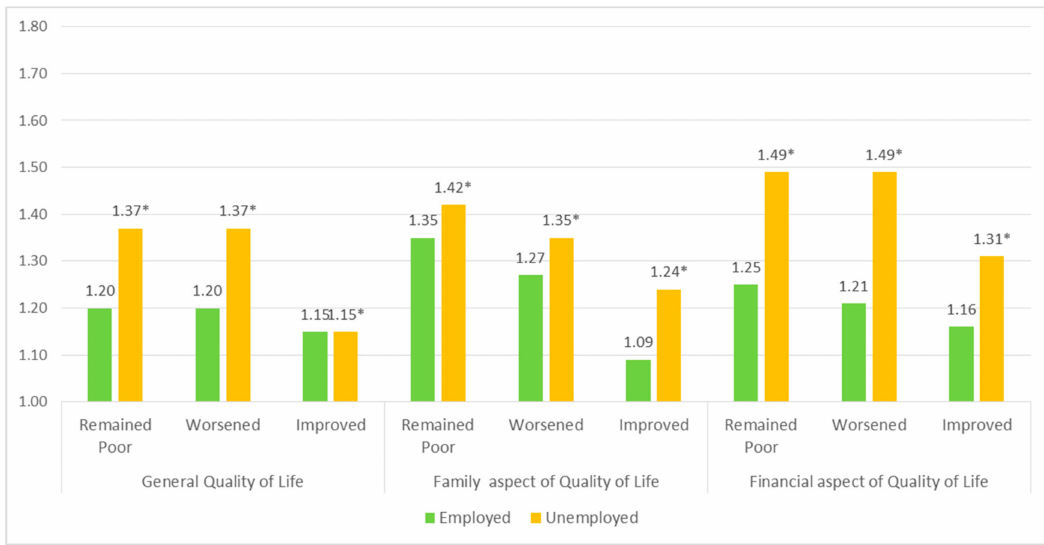
Figure 2. Subgroup analysis on employment status: qualitive life with low cognitive function † measured by MMSE ‡ score. † Low: MMSE ≤ 23, normal: 24 ≤ MMSE; ‡ Mini- Mental State Examination (MMSE); * Statistically significant